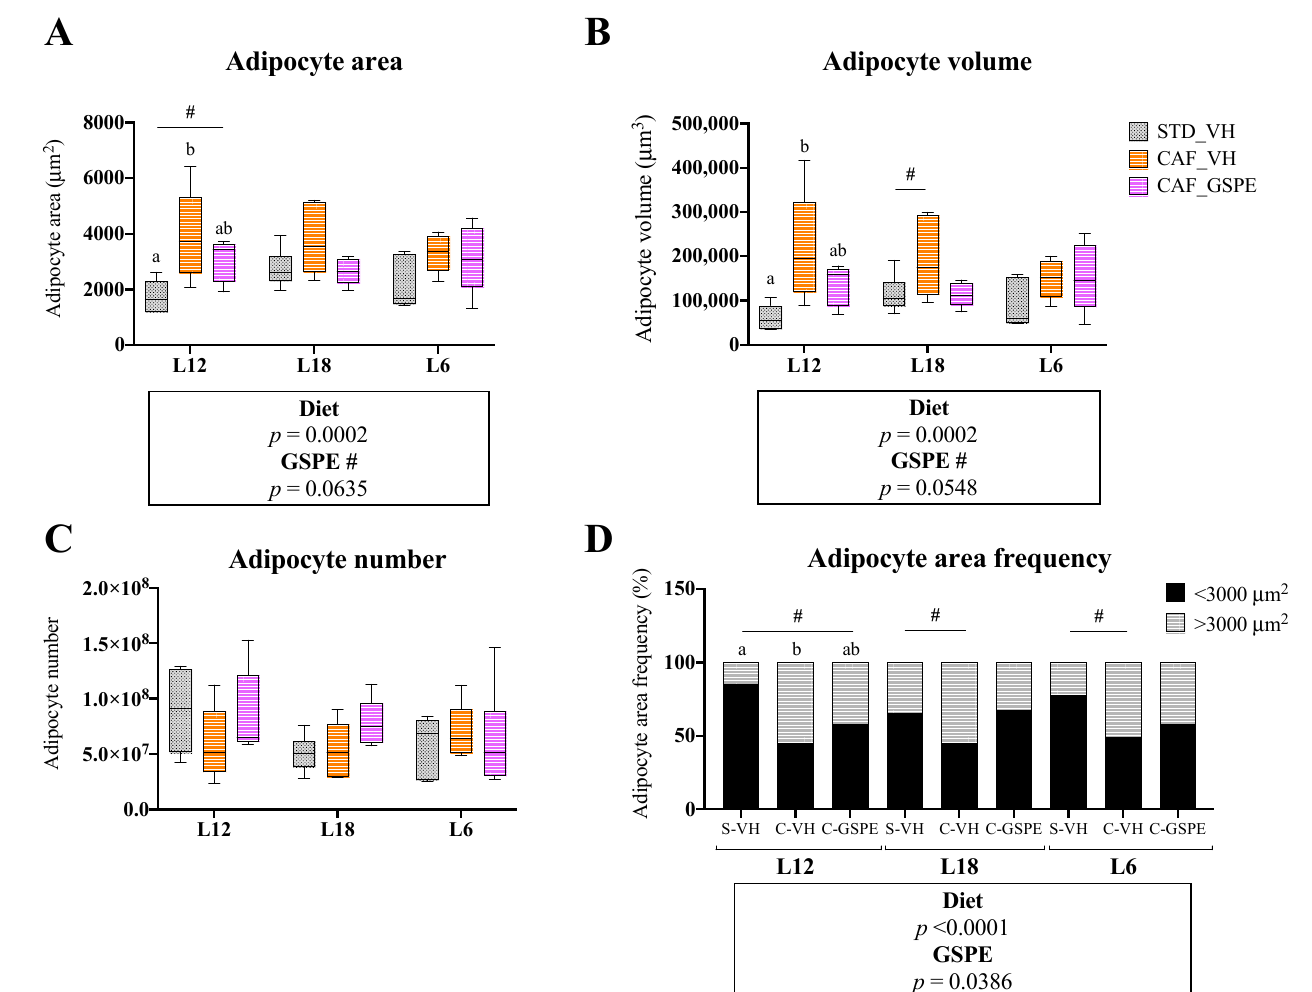
Figure 1. Adipocyte area ( A ), adipocyte volume ( B ), adipocyte number ( C ) and adipocyte area frequencies ( D ) of inguinal white adipose tissue (iWAT) of rats treated with grape seed proanthocyanidin extract (GSPE) at different photoperiods, 12 h of light:12 h of darkness (L12); 18 h of light:6 h of darkness (L18); 6 h of light:18 h of darkness (L6). Histological study of iWAT morphology of Fisher 344 rats fed with standard diet (STD) or cafeteria diet (CAF) for 9 weeks and treated with GSPE (25 mg/kg body weight) or vehicle (VH) the last 4 weeks of the study; STD-VH group; CAF-VH group; CAF-GSPE group, under different photoperiods; L12, L18 or L6. For adipocyte area frequency, adipocytes were distributed in two groups according to their areas (<3000 or >3000 µ m 2 ). The results are presented as the mean ± SEM ( n = 6). Significant differences were assessed through two-way ANOVA analysis ( p < 0.05). Diet: diet effect within VH groups; GSPE: GSPE consumption effect within CAF groups; # : tendency (0.05 < p < 1). Different letters denote significant differences within each photoperiod group (assessed with one-way ANOVA followed by Tukey’s post hoc test, p < 0.05; # : tendency: 0.05 < p < 1)